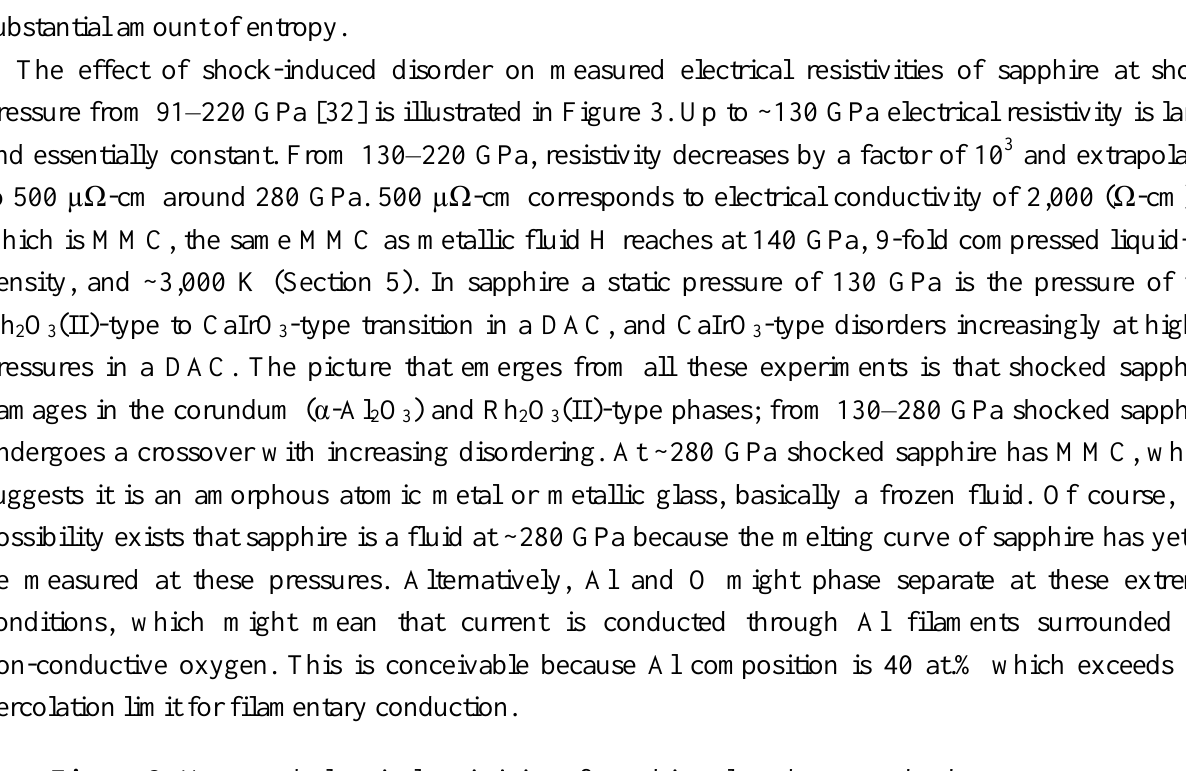
Figure 3. Measured electrical resistivity of sapphire plotted versus shock pressure up to 220 GPa